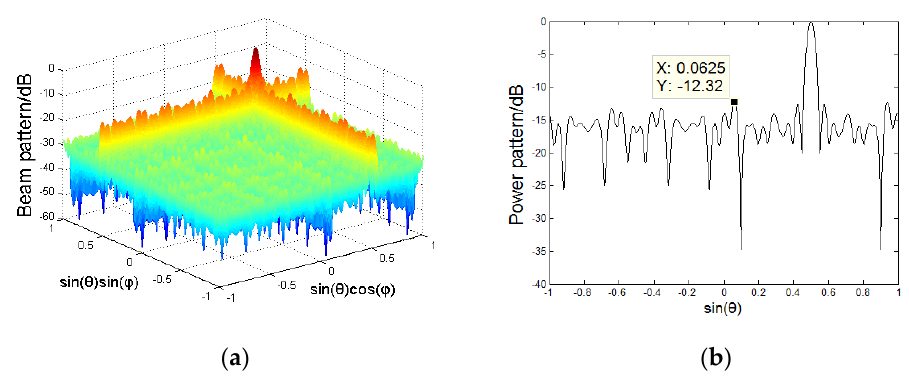
Figure 9. Beam power pattern of the obtained array after employing the CDS method. ( a ) 3D pattern; ( b ) 2D section pattern.